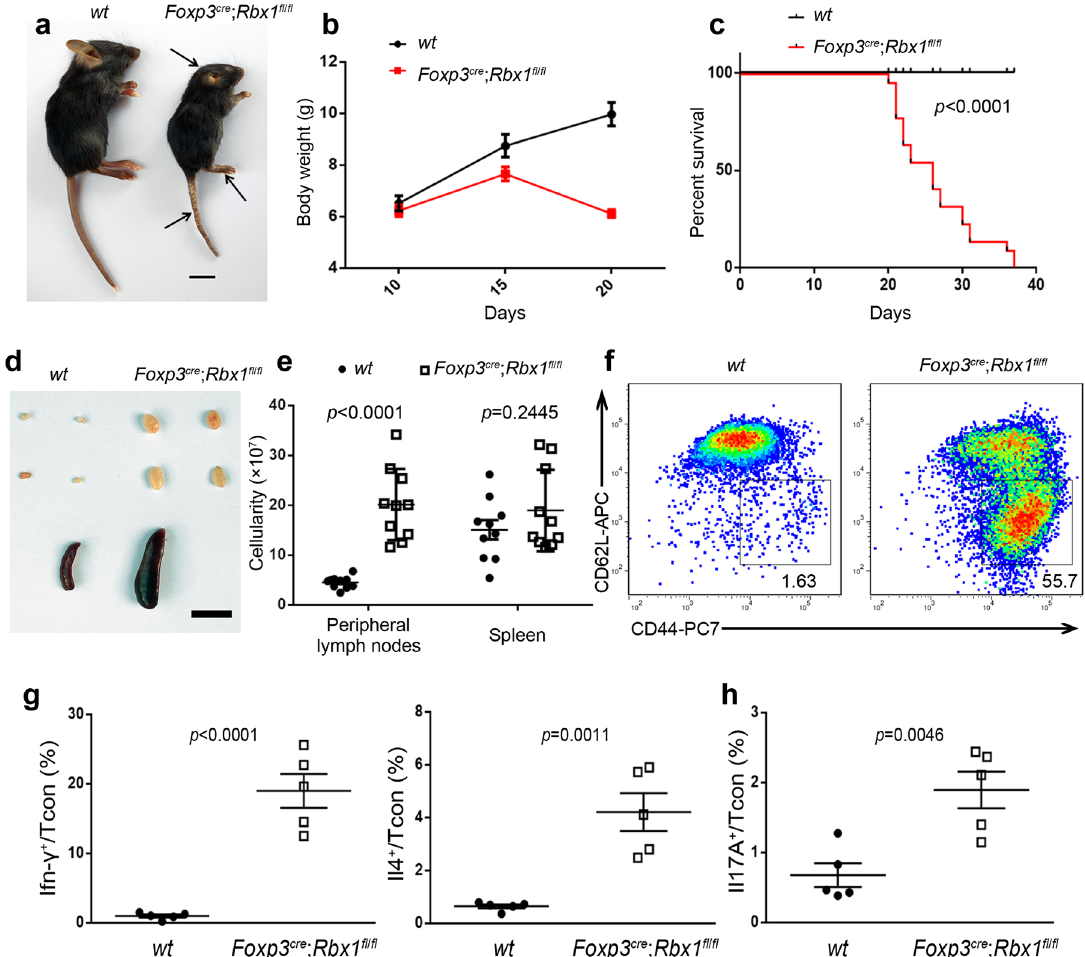
Fig. 1 Rbx1 deletion in Treg cells leads to an early-onset fatal in fl ammatory disorder. a Representative images of wt and Foxp3 cre ; Rbx1 fl / fl mice (p20, male, scale bar = 1 cm). b Gross body weight of wt and Foxp3 cre ; Rbx1 fl / fl mice (p19 – 23, n = 10 animals, for gender information see “ source data ” ). c Survival curve of wt and Foxp3 cre ; Rbx1 fl / fl mice ( n = 21 animals from both male and female mice, p < 0.0001). d Representative images of the peripheral lymph nodes (top) and spleen (bottom) from wt and Foxp3 cre ; Rbx1 fl / fl mice (p22, male, scale bar = 1 cm). e Total cell numbers in peripheral lymph nodes and spleen from